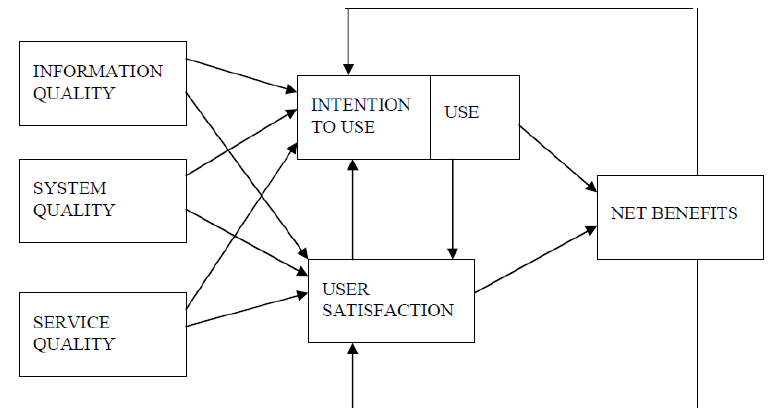
Figure 1. The DeLone and McLean updated theoretical model 15